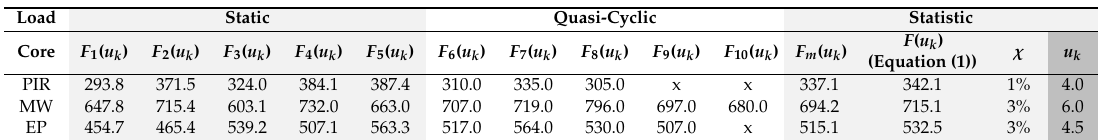
Table 7. Axial pull-out—comparison of the force from laboratory tests: F i ( u k ) [N], F m ( u k ) [N] and analytical calculations F ( u k ) [N].